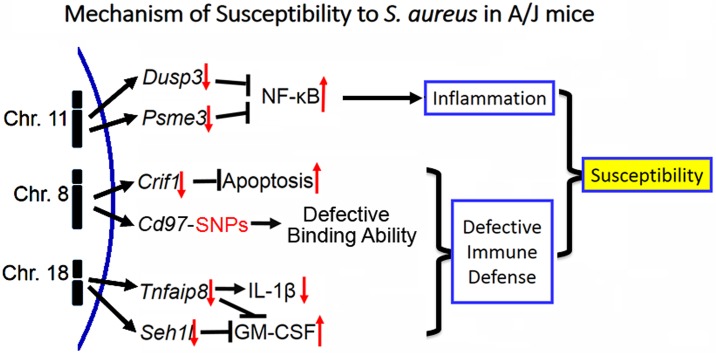
Proposed mechanism of susceptibility to S. aureus in A/J mice. Summary of candidate gene function in A/J mice responsible for S. aureus susceptibility.Down-regulation of Dusp3 and Psme3 from chromosome 11 enhances inflammation upon S. aureus infection by activation of NF-κB signaling. Down-regulation of Crif1 from chromosome 8 compromises host immune defense against S. aureus by increasing apoptosis. Non-synonymous SNPs in Cd97 alters ligand binding ability. Down-regulation of Tnfaip8 and Seh1l from chromosome 18 increase the production of GM-CSF and lower expression of Tnfaip8 decreases the production of IL-1β.